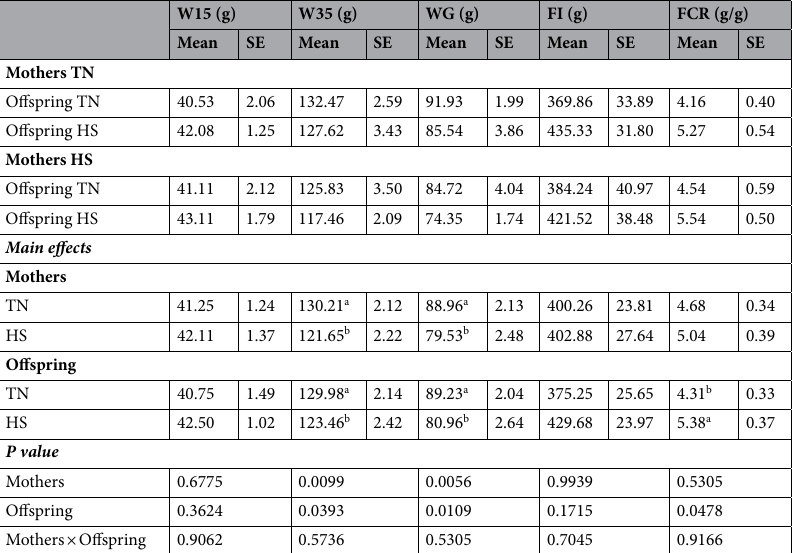
Table 3. Performance of Japanese quail ( Coturnix coturnix japonica ) chicks raised under thermoneutral or heat stress conditions ( n = 25). Results are presented as mean and standard error (SE). W15 chick weight at 15 days of age, W35 chick weight at 35 days of age, WG weight gain, FI feed intake, FCR feed conversion ratio, TN thermoneutral, HS heat stress. a,b Different subscript letters in the same column indicate a significant difference by the t test ( P < 0.05).